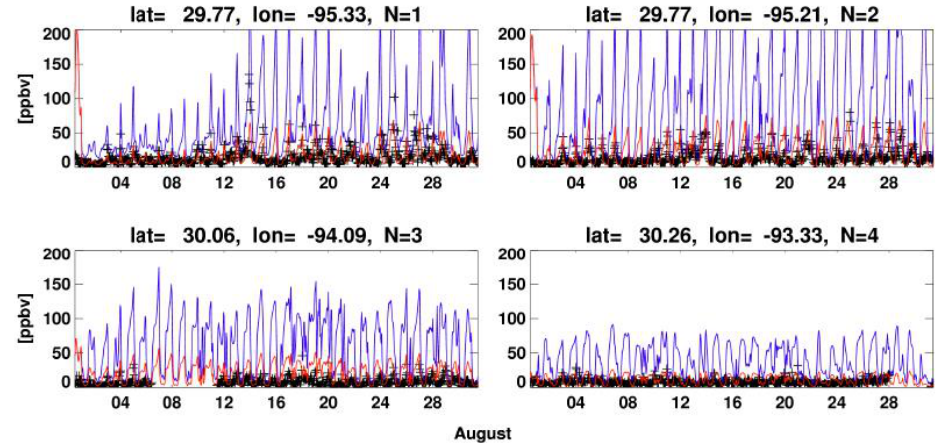
Fig. 8. Surface NO x concentrations at EPA AQS stations (black crosses), corresponding baseline CMAQ simulations with baseline emissions, BASE2009 (blue), and CMAQ simulations with GOME-2-adjusted NO x emissions, GOME2009 (red) at the four station grids (see the right panel of Fig. 7, 1: Houston A, 2: Houston B, 3: Beaumont, and 4: Sulphur) in August 2009.